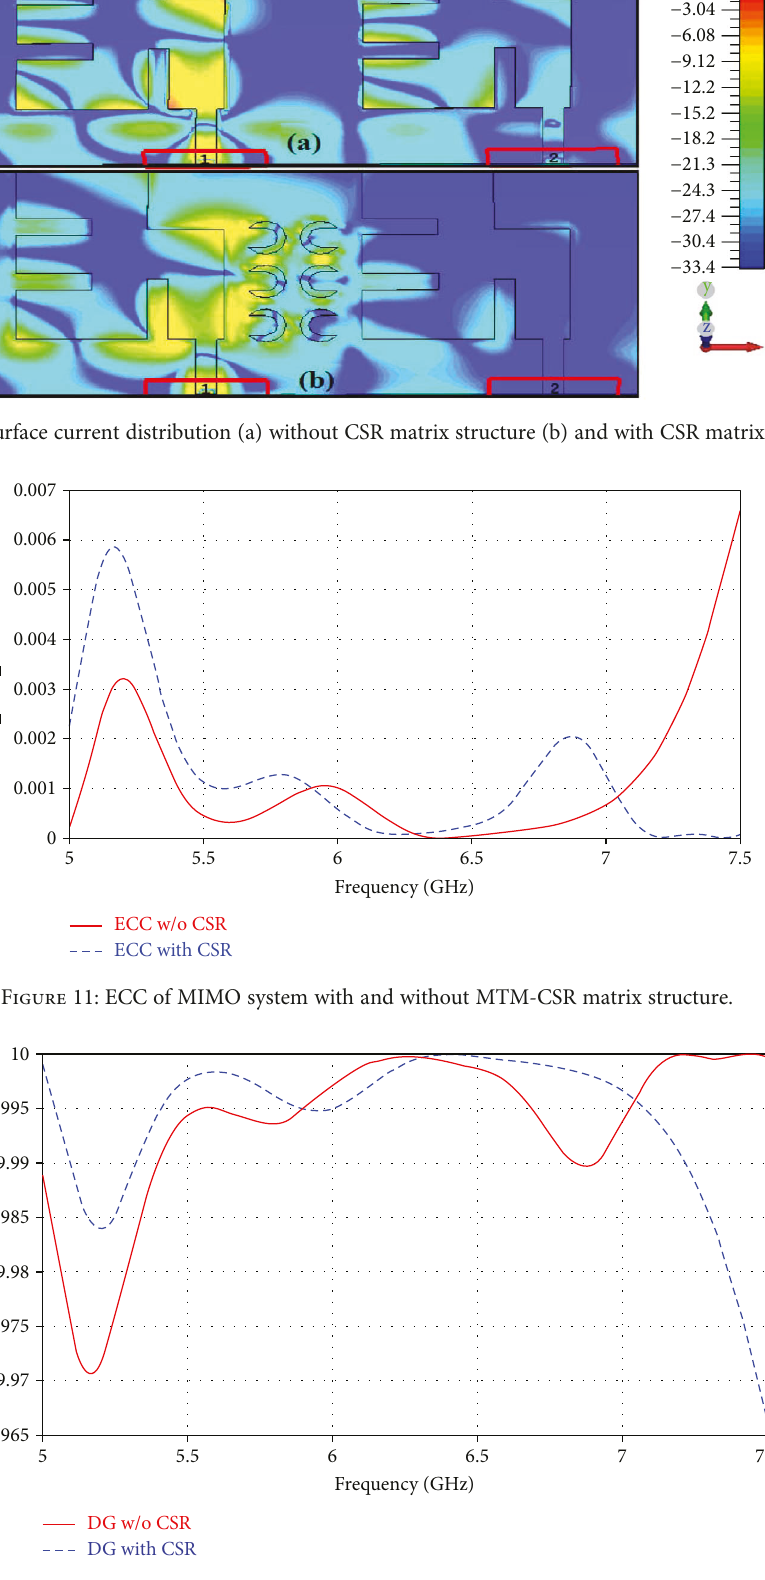
Figure 12: Diversity gain of the MIMO antenna with and without MTM-CSR matrix